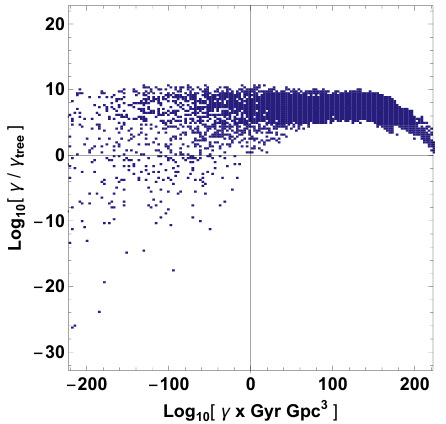
Figure 2 . The di(cid:11)erence between the tree level vacuum decay rates and the one-loop level vac- uum decay rates. We use the data accumulated for (cid:12)gure 4. We show only (cid:0) 200 . log (cid:2) GyrGpc 3 ] .